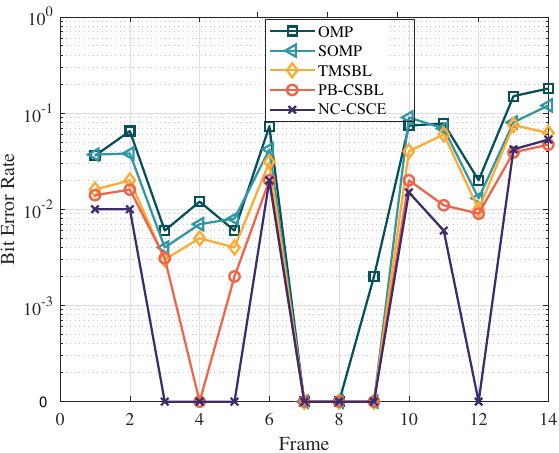
Figure 8. The comparison of BER performance in the lake